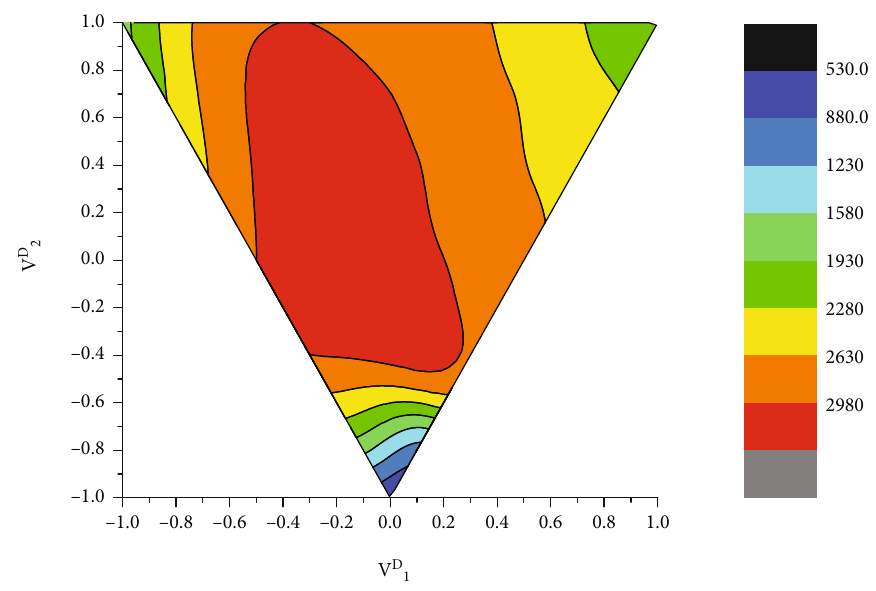
− V 0 plane with ½ V A 1 2